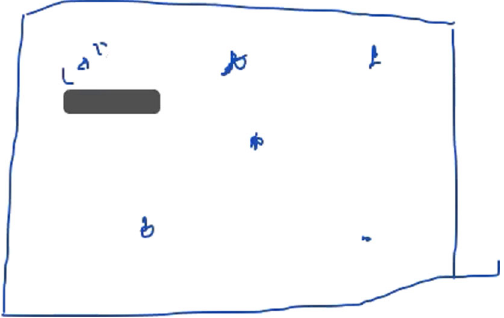
FIG. 9. Hela ’ s sketch as constructed in Table V. Hela has just added action lines to the molecule on the top left corner; line 21 in the transcript.